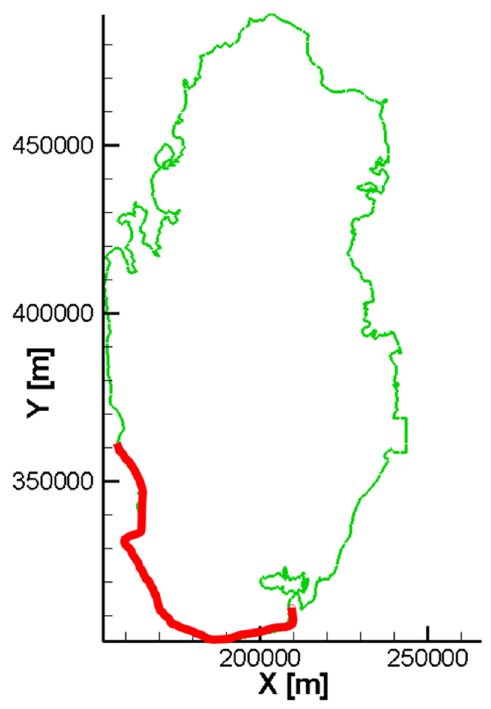
Figure 4. Boundary conditions for the hydrogeological model (Dirichlet in green, Neumann in red).